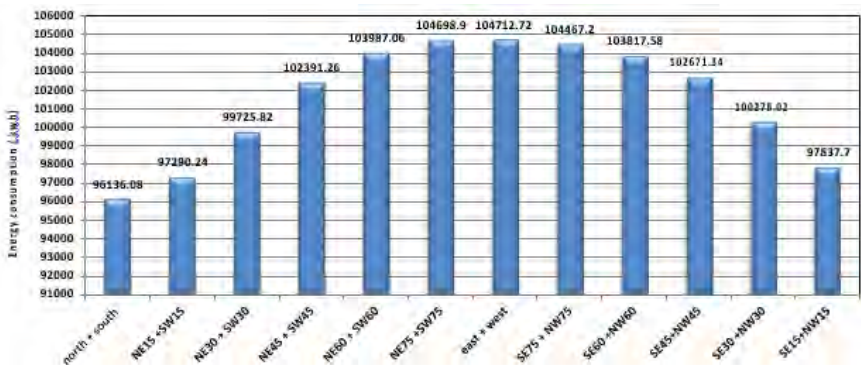
Figure 8. Total energy consumption of the model compound annually in different